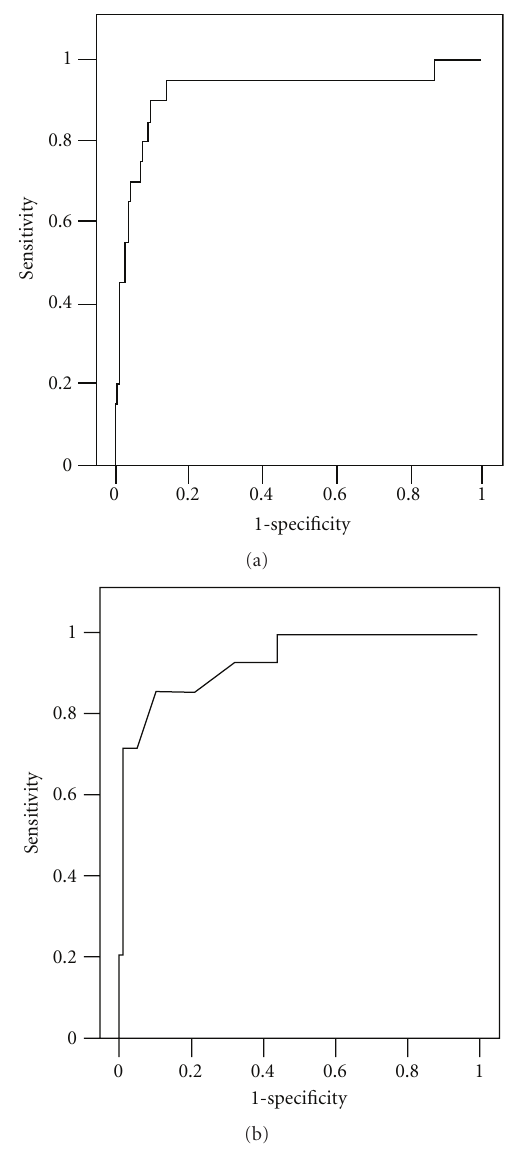
Figure 1: Receiver operating characteristic (ROC) curve of the best multivariate logistic regression analysis model for predicting mild to moderate Alzheimer’s disease among diabetic elderly subjects (a) and nondiabetic individuals (b). The area under the curve (AUC) was 0.97 (a) and 0.93